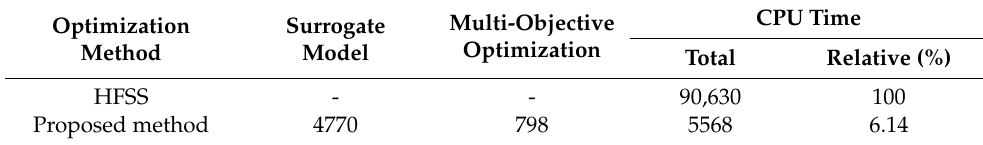
Table 6. Time comparison of different antenna optimization methods (unit: s).